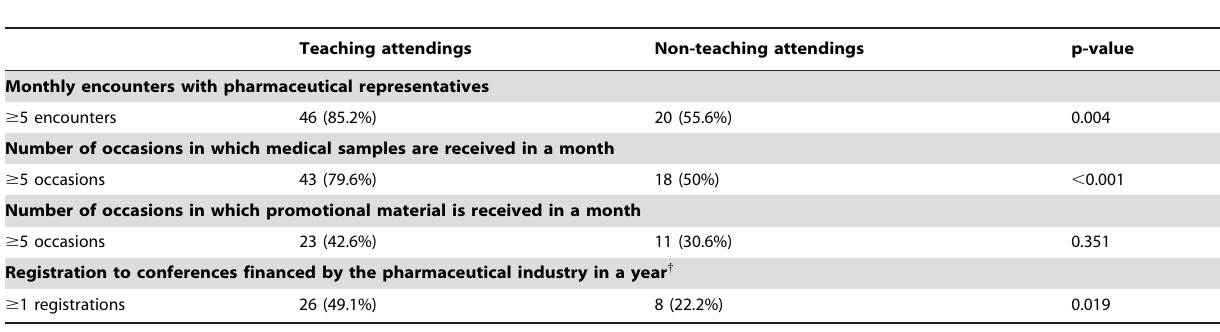
Table 4. Participation in activities and acceptance of gifts from industry stratified by teaching